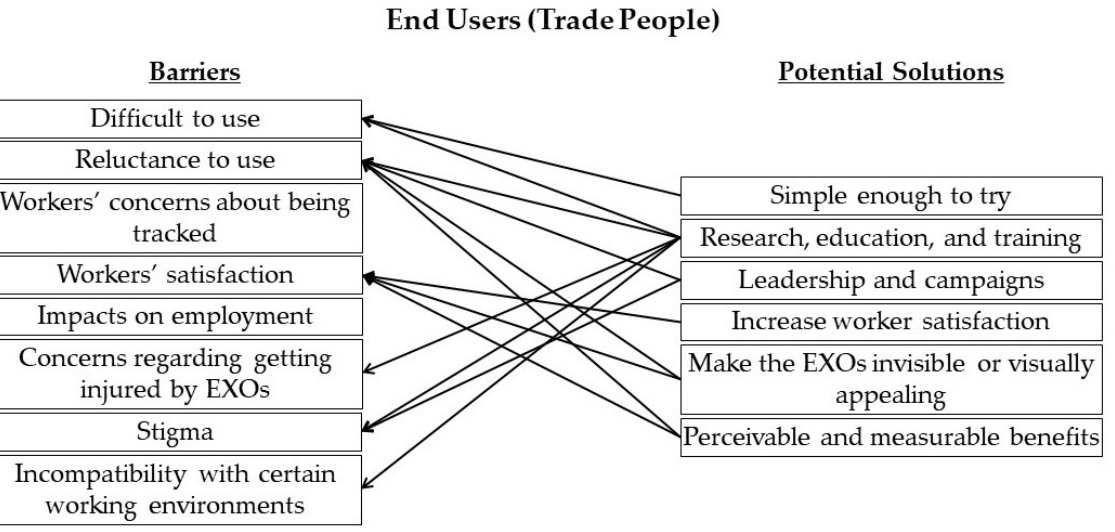
Figure 7. Mapping of potential solutions to identified barriers in the end users (trade professionals) category.